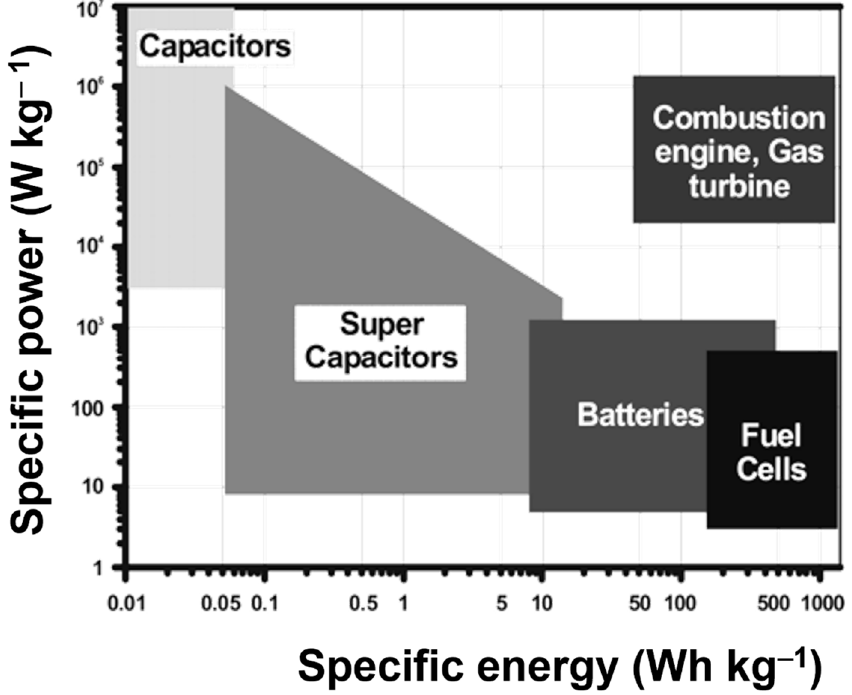
Figure 1. Ragone plot for the various electrochemical energy storage devices. Reproduced with permission from [22]. Copyright 2004 American Chemical Society.